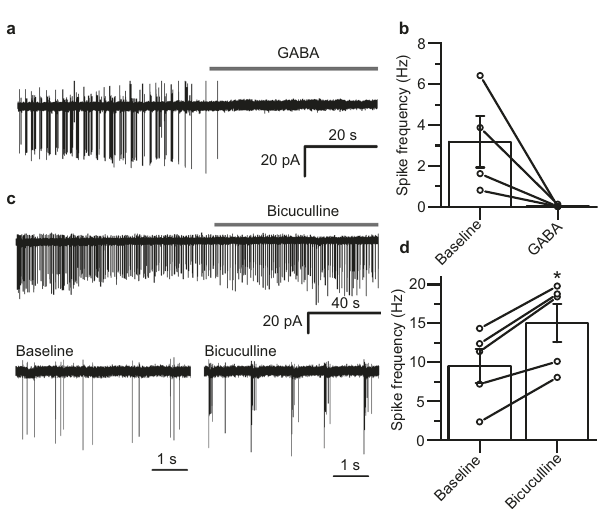
Fig. 7 GABA is inhibitory under conditions that induce iLTP. a Extracellular spike currents recorded from a cultured hippocampal neuron in cell-attached voltage-clamp mode showing the response to 1 mM GABA application. b Summary of spike current frequencies before and after GABA exposure, n = 4 neurons. c Representative current trace recorded from a cultured hippocampal neuron in cell-attached voltage-clamp mode showing the response to bicuculline (50 µ M) application — two segments of the recording are also shown below with higher time resolution. d Summary of spike current frequencies before and after bicuculline application, n = 5 neurons (paired-sample t-test: t (4) = − 7.87, p = 0.0014). Baseline measures signify the spike fi ring rate before any treatment. Source data are provided as a Source data fi le for Fig.